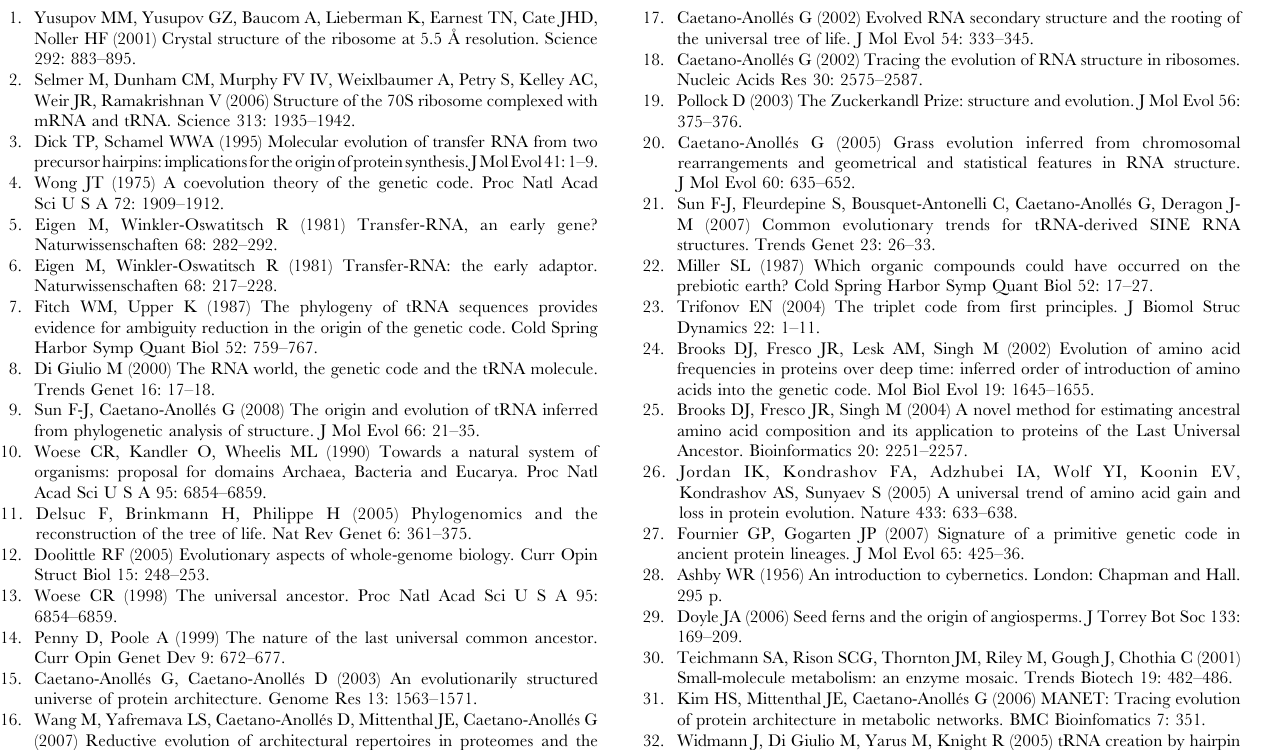
Table S1 Taxonomic distributions of the 571 tRNA molecules examined in the phylogenetic study.